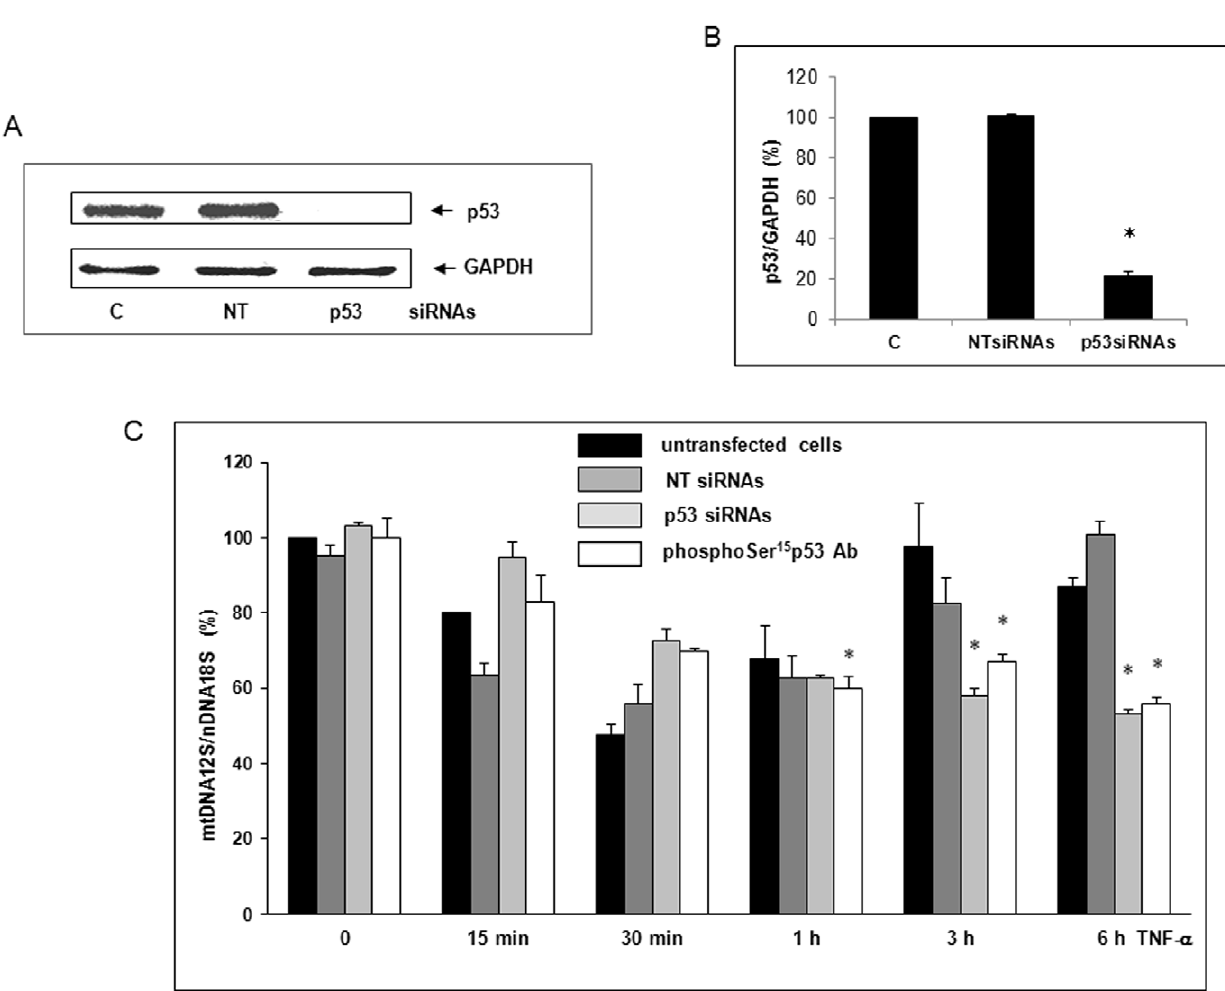
Figure 6. p53 inhibition by siRNAs and phosphoSer 15 p53 antibody prevented the reversion of mtDNA depletion. (A) All siRNA transfections were performed with 12.5 nM siRNAs directed against p53 mRNA (p53 siRNAs) or non-targeting siRNAs (NT) and DharmaFECT4 H transfection reagent used as a control (c). To check siRNA transfection efficiency, Western Blots were performed at 48 h using p53 or GAPDH (loading control) antibody. (B) The knockdown of p53 expression by siRNAs relative to GAPDH was quantified using the Bio1D software (mean values 6 SEM of three experiments *p , 0.05) (C) DNA was isolated from untransfected cells or transfected with NT siRNAs or with p53 siRNAs. Cells were also permeabilized with 0.1% Triton X100 and pretreated for 1 h with 1 m g/ml phosphoSer 15 p53 antibody (phosphoSer 15 Ab). Cells were then treated for 0 to 6 h with 30 ng/ml TNF- a . The quantification of mtDNA content was performed by simultaneous real-time qPCR amplification of fragments encoding mitochondrial 12S rRNA and nuclear 18S rRNA serving as a reference gene. Results are expressed in mtDNA over nDNA relative ratio (mean values 6 SEM of three independent experiments with five replicates, *p , 0.05).